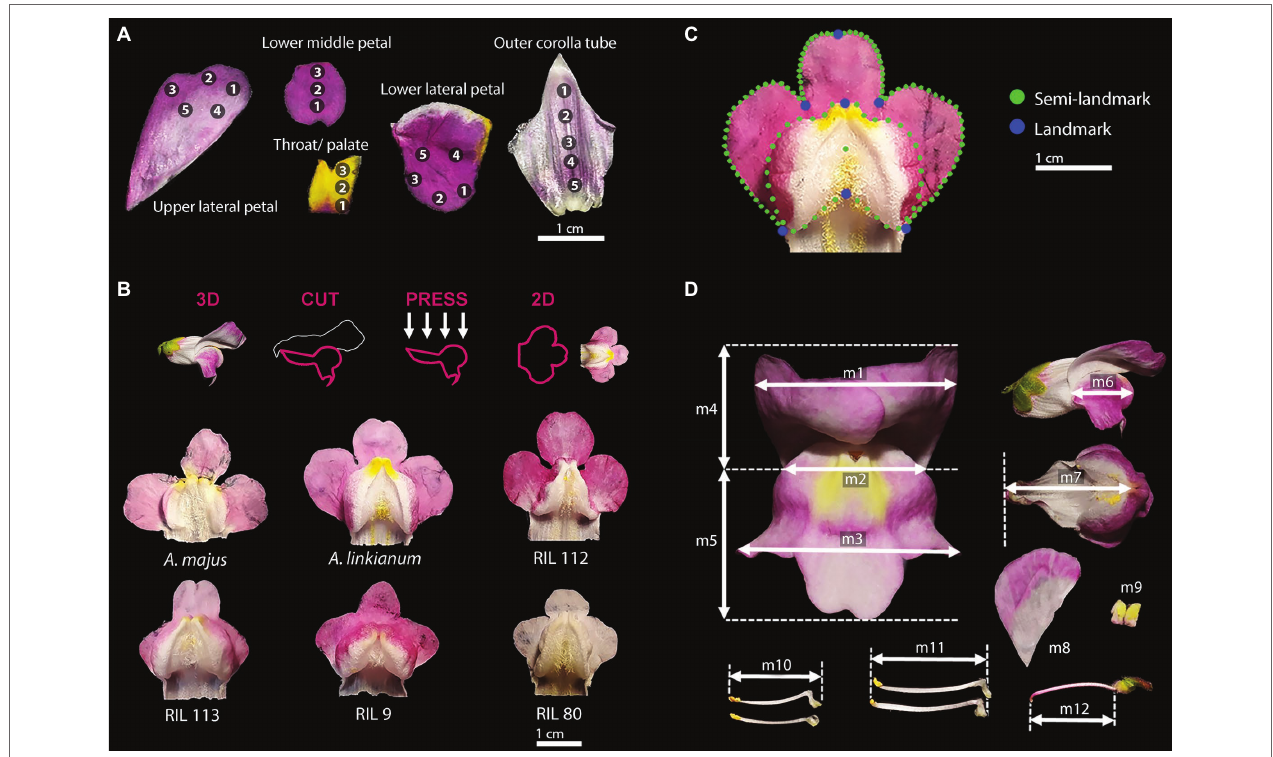
FIGURE 2 | Floral parts phenotyped. (A) Floral parts used to measure the colour of flowers. Numbers indicate the location of measurements on each floral part. (B) Dorsal and lateral petal lobe dissection used to analyse floral morphology. (C) Landmarks and semilandmarks used to analyse floral morphology. (D) Location of floral size measurements for each flower. Length of front (M1–5), lateral (M6), lower lobe (M7), short and long stamen (M10 and M11), and gynoecium (M12). Area of upper lateral petal (M8), throat/palate